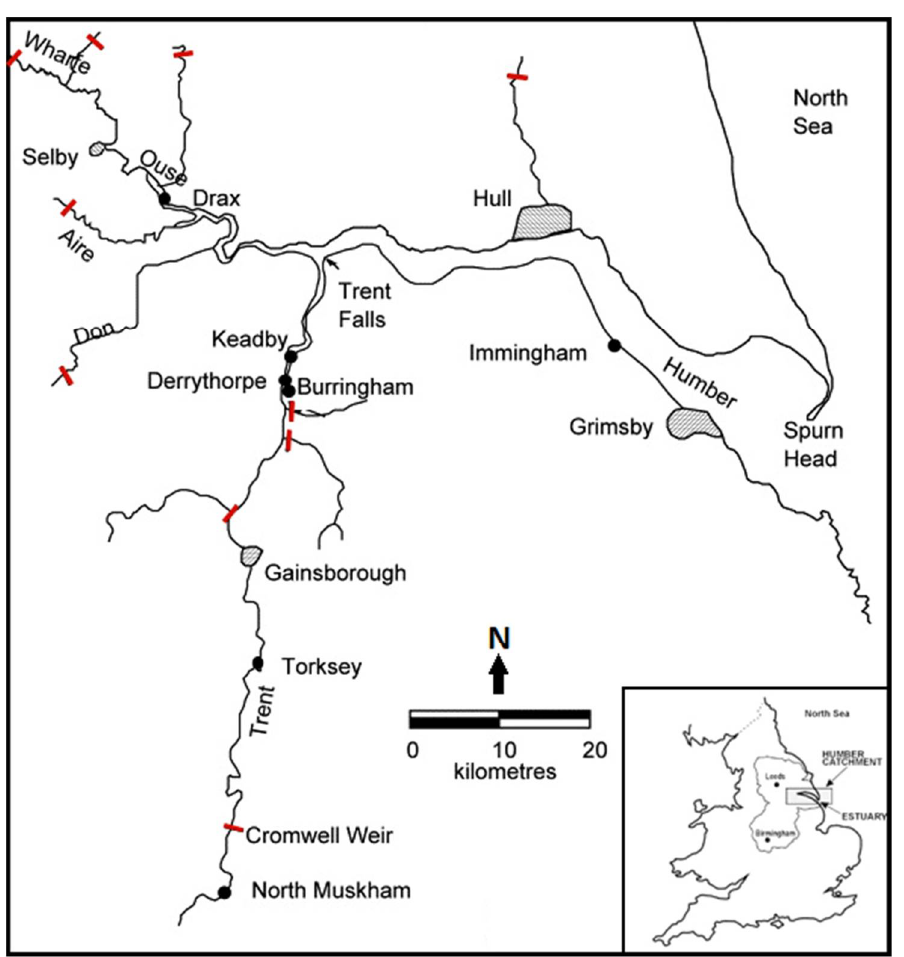
Figure 1. The Humber Estuary system. Inset shows the location of the Humber Estuary in the UK [44,45]. Tidal limits are indicated as red bars crossing the channel.